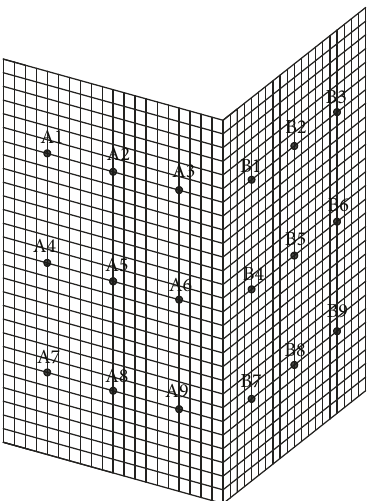
Figure 12: Location of points selected for calculation of displacement vibration coefficient.